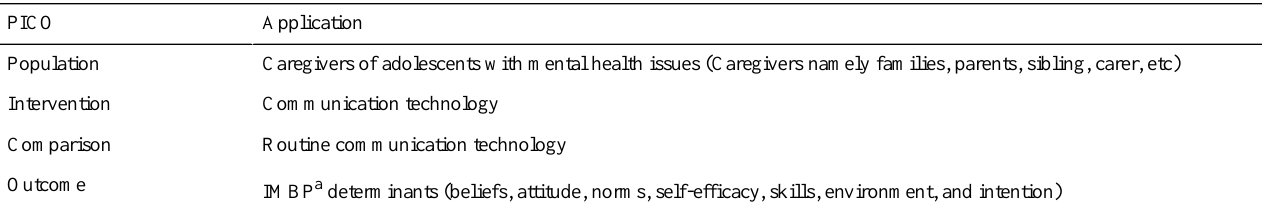
Table 1. Application of the PICO format.